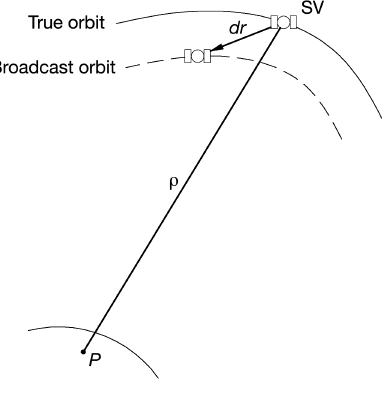
Figure 1. Ephemeris error: dr is the radial residual satellite position error, ρ is the pseudorange measurement and P is the point where receiver is